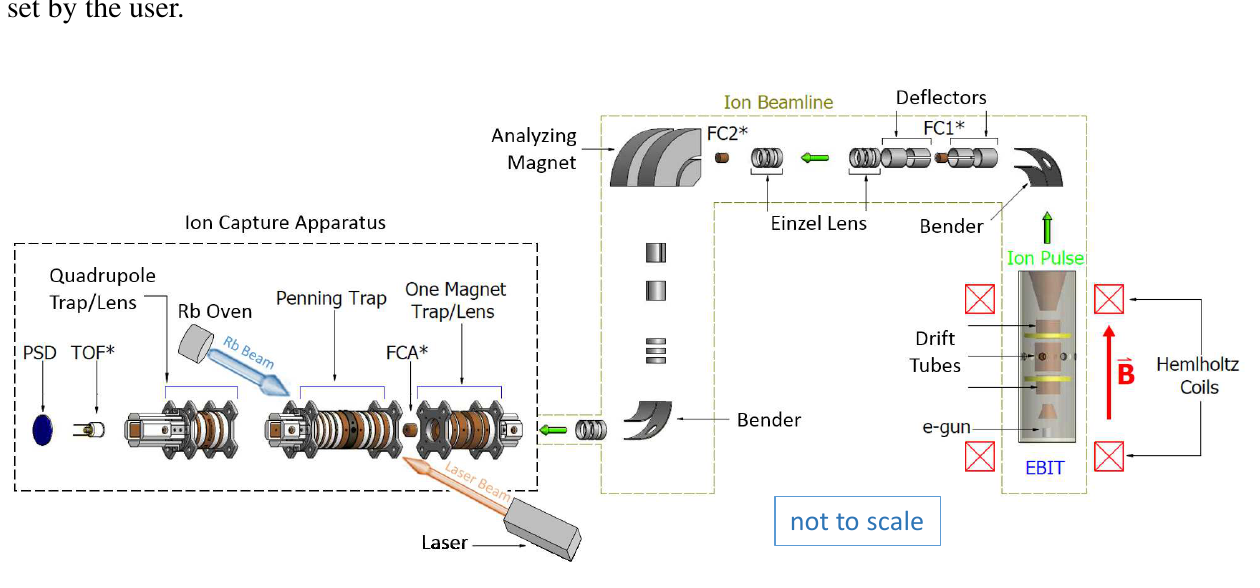
Figure 4. Overview of the experimental setup. The ion source is an electron beam ion trap (EBIT) (far right). The ion extraction beamline has an analyzing magnet for charge state selection and several Faraday cups (FC) to monitor the ions along the beamline. A unitary Penning trap has been installed at the end of the beamline to capture extracted ions. An atomic oven is used to send a Rb beam into the Penning trap where the atoms are excited by a laser. A time-of-flight (TOF) detector and a position-sensitive detector (PSD) are used to analyze the captured ions. Broken lines represent the boundary of evacuated space. Beamline elements labeled with an asterisk (*) are